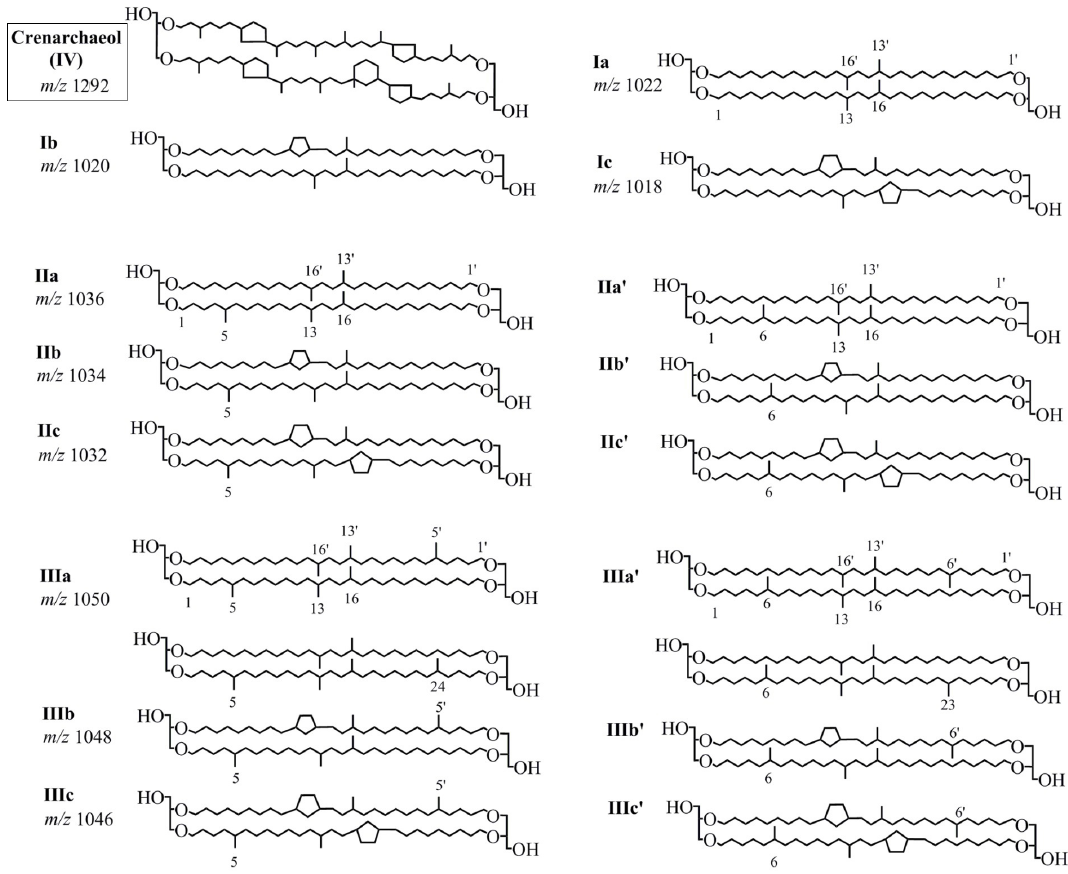
Figure 2. Chemical structures of brGDGTs and crenarchaeol.